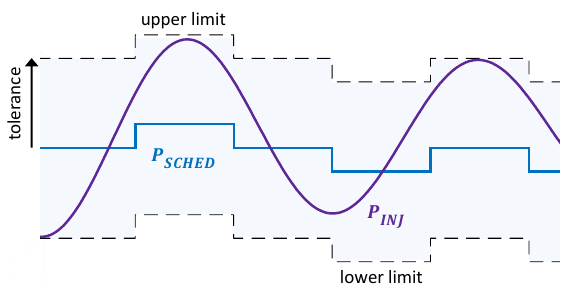
Figure 17. HPP power injection